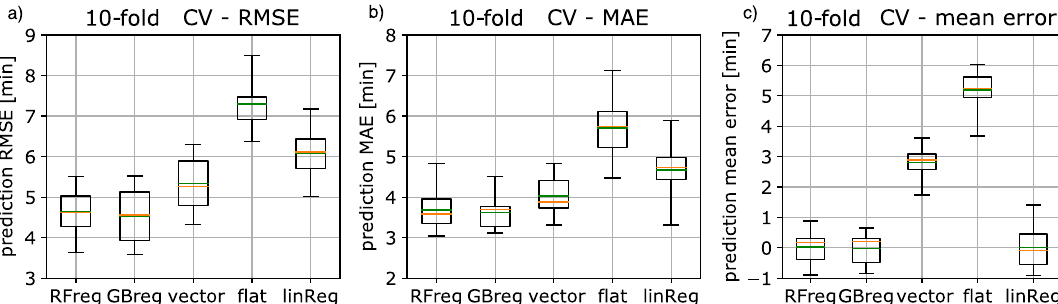
Fig. 5. Comparison of model performance based on a 10-fold cross validation (CV) between random forest (RFreg), gradient boost (GBreg), vector delay, fl at delay, and basic linear regression (linReg) shown as box plot for the performance metrics (a) RMSE, (b) mean absolute error (MAE) and (c) mean error . Each box contains 10 folds from the cross-validation, its mean is shown in green, the median in orange, the box edge shows the 25/75 percentile and the whiskers indicate the full range.